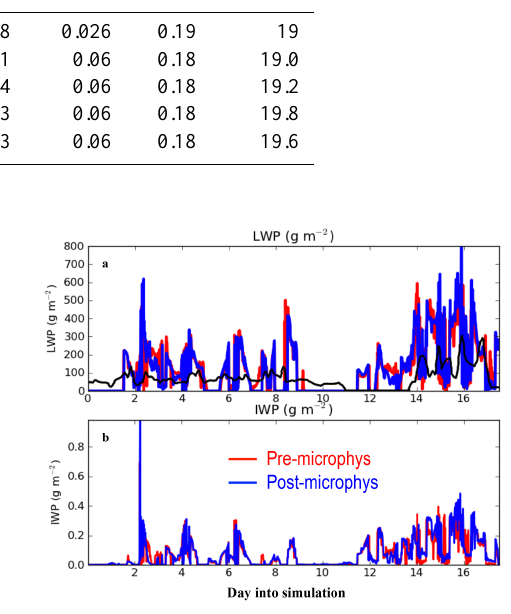
Figure 9. Time series of (a) LWP and (b) IWC during the ARM95 IOP period. The solid black line in (a) gives observations from Xu and Randall